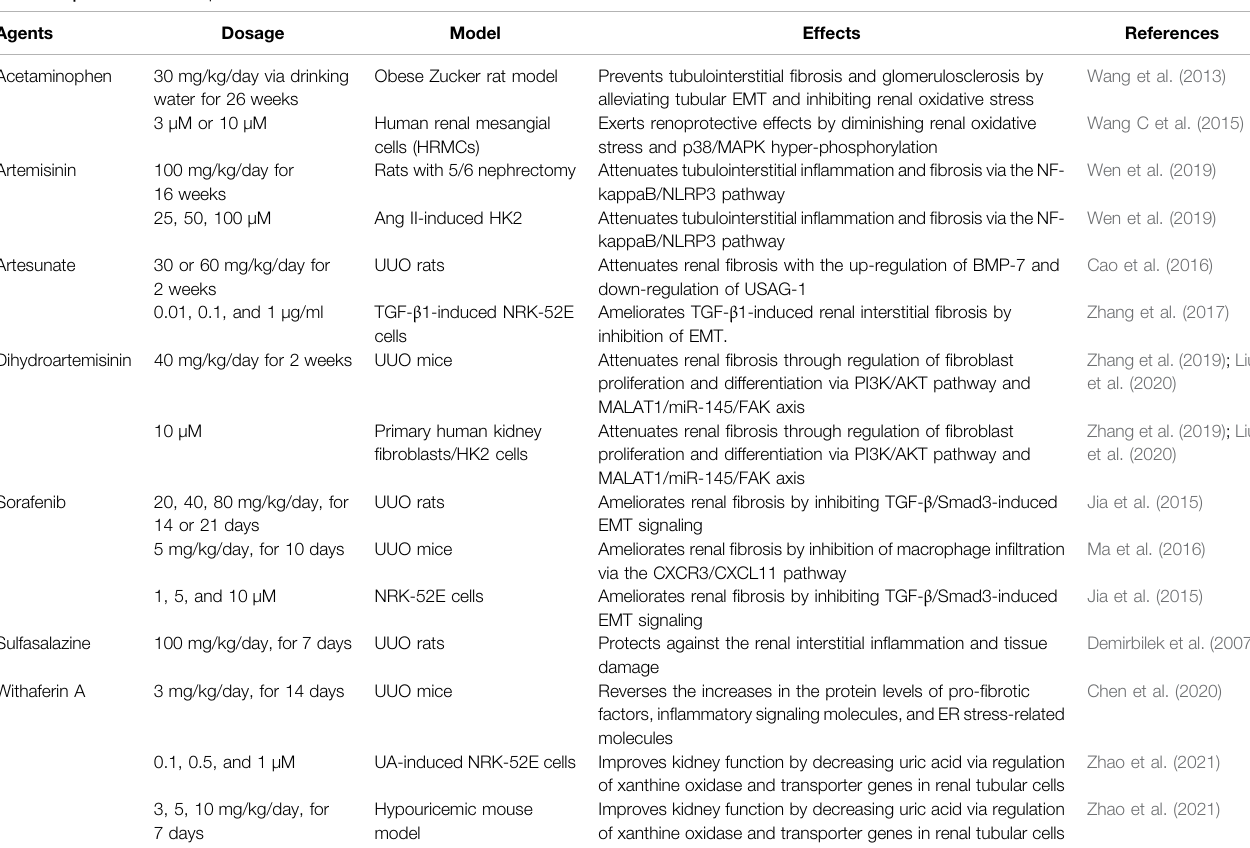
TABLE 4 | Evidence of ferroptosis inducers alleviates renal fi brosis in vitro and in vivo .